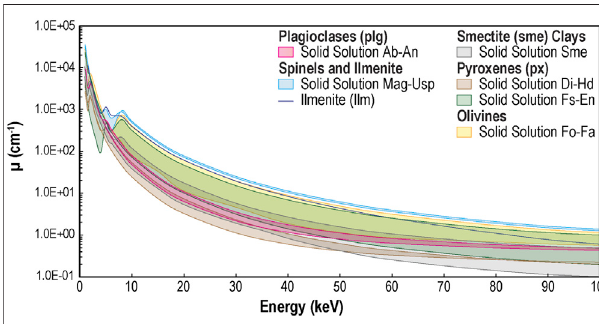
FIGURE 1 | Overlapping linear attenuation coef fi cients, µ, of major primary minerals and the secondary smectite clay group commonly found in basalts. Minerals are typically solid solutions in between endmembers and their composition (represented by shading) can occupy a range based on the deviation from endmember chemistry. Titano-magnetite falls within the magnetite(Mag)-ulvöspinel(Usp)solidsolutionseries. SupplementaryTable S1 presents the mineral names, their abbreviations, groups, chemical formulas, and densities used in µ calculations. Individual endmember graphs are detailed in Supplementary Figure S1